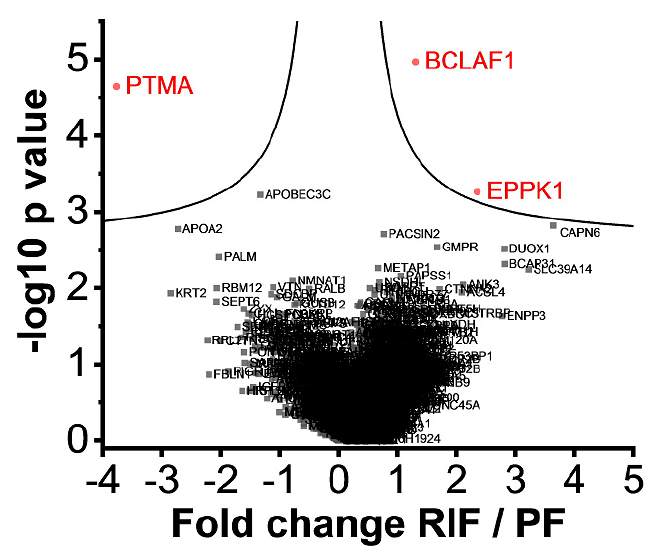
Figure 1. Volcano plots of the proteomic analysis of repeated implantation failure (RIF) endometrial tissue ( n = 6) vs. proven fertility (PF) ( n = 10). All identified proteins are shown with their associated gene names. Proteins showing a significantly altered abundance are highlighted in red.